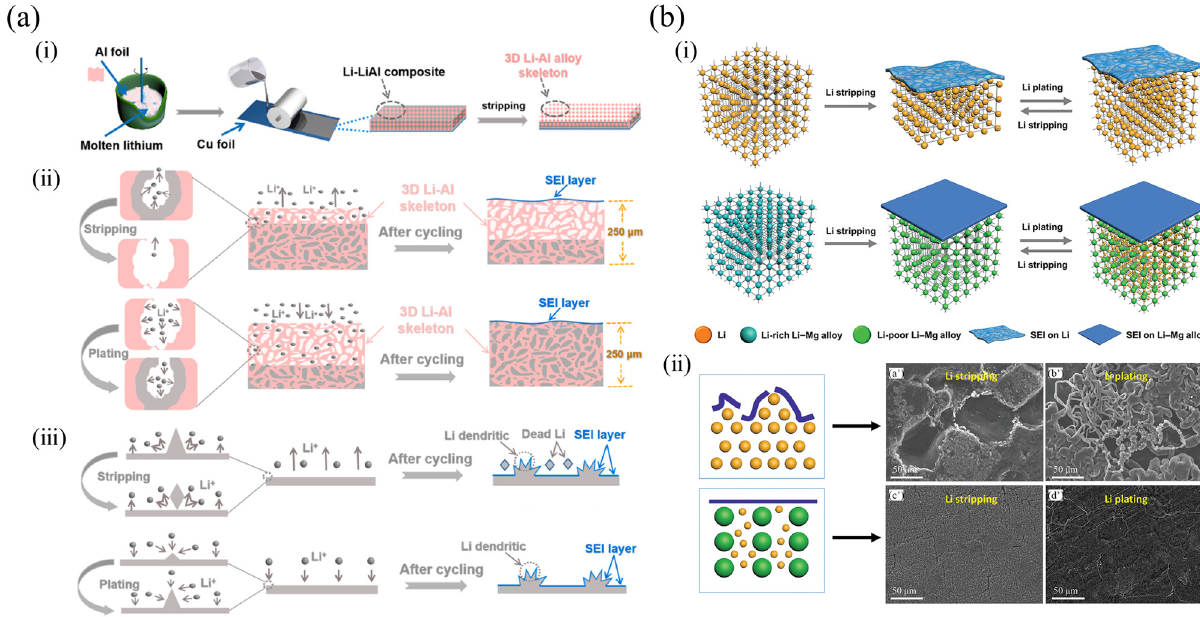
Figure 2: ( a ) Schematic diagrams of ( i ) preparation of Li – LiAl composite electrode, ( ii ) Li stripping/plating of Li – LiAl composite electrode, and ( iii ) Li stripping/plating of bare Li electrode, reprinted with permission from ref. [ 21 ] ; ( b ) schematic structure diagram of ( i ) in the bulk and at the surface for Li and Li – Mg alloy anodes during Li stripping/plating process, and ( ii ) SEM images of Li and Li – Mg alloy after ( a ′ , c ′ ) Li stripping and ( b ′ , d ′ ) following Li plating at 0.5 mA cm − 2 for 24 h in Li/Cu and Li – Mg/Cu coin cells, reprinted with permission from ref. [ 23 ] .